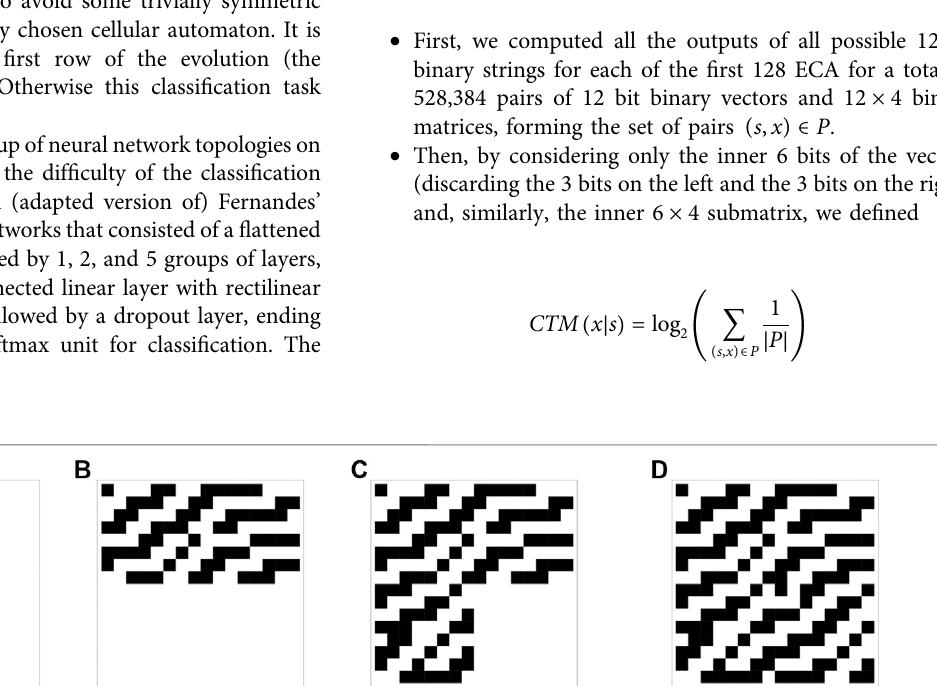
Frontiers in Arti fi cial Intelligence |